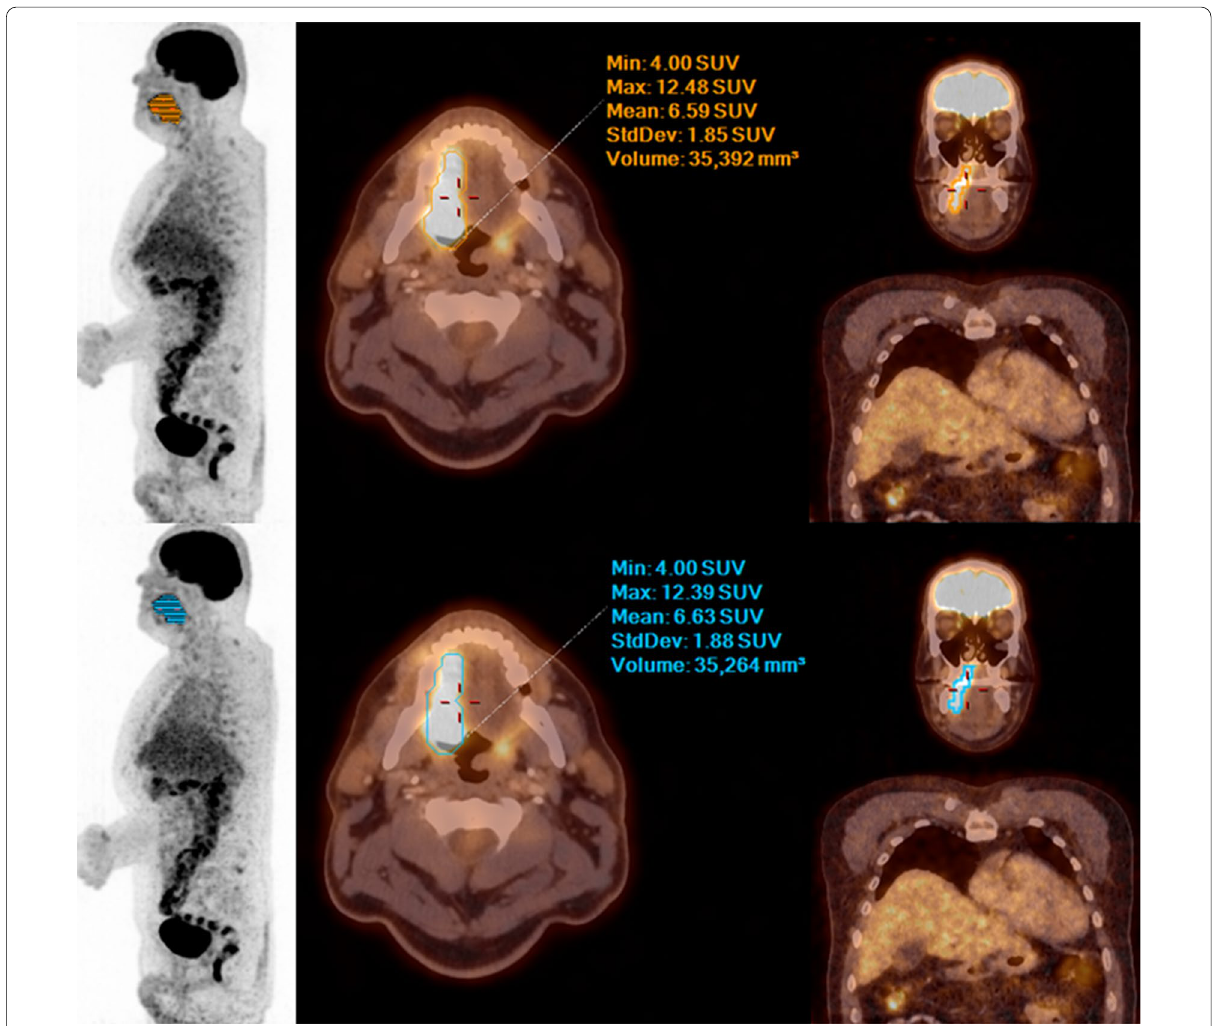
Fig. 3 MIP, fused axial and coronal PET/CT images (from left to right) with 75 s (upper row )and 57 s (lower row) PET acquisition time per bed position of a 57‑year‑old male patient with 105 kg bw suffering from head & neck cancer—no significant difference in image quality, lesion detectability and